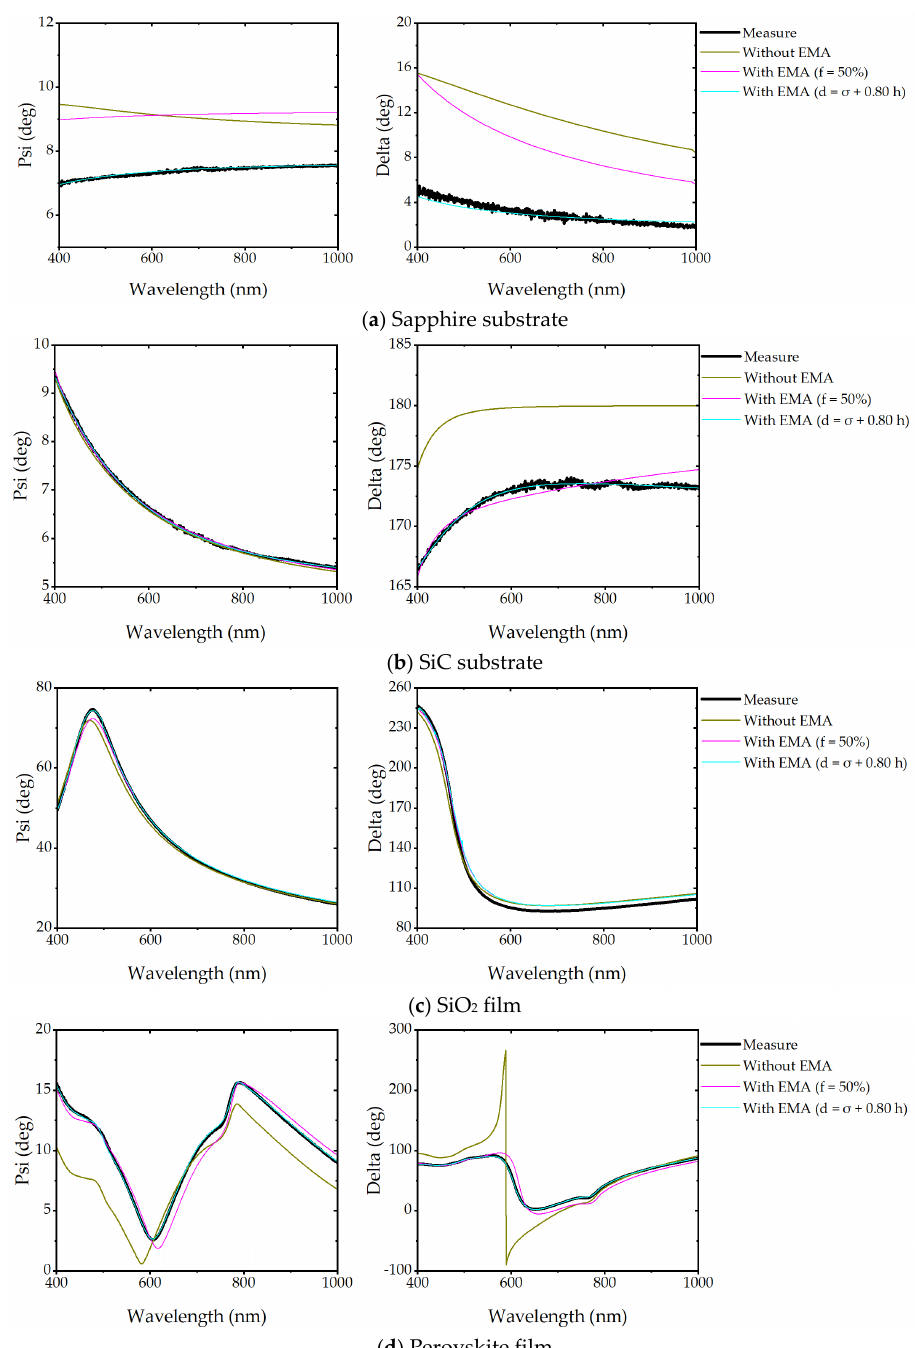
Figure 10. Fitting curves of measured ellipsometric parameters and without EMA layer and with established EMA layer. ( a , b ) represent bare sapphire and bare silicon carbide substrate, respectively; ( c ) represents silicon substrate with silicon oxide thin film; ( d ) represents perovskite thin film deposited on the sapphire substrate.